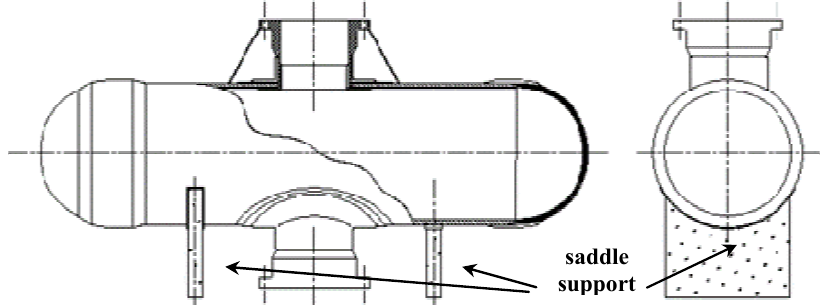
Figure 1. Horizontal pressure vessels with two saddle supports.